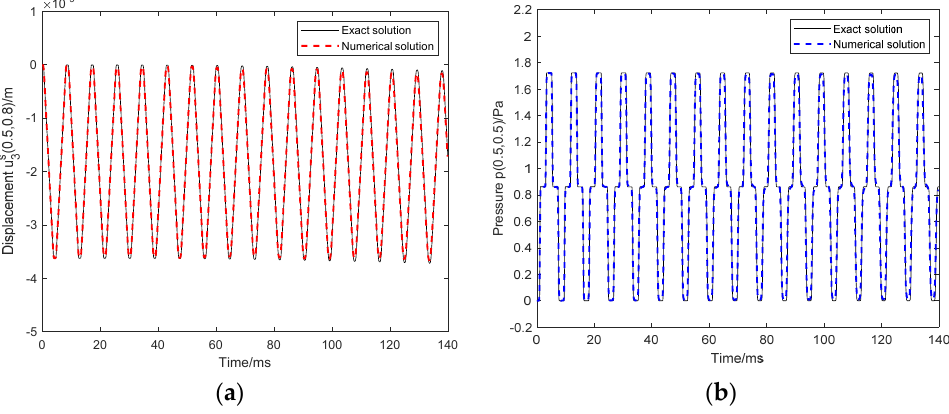
s u at (0.5, 0.8) and ( b ) p at (0.5, 3